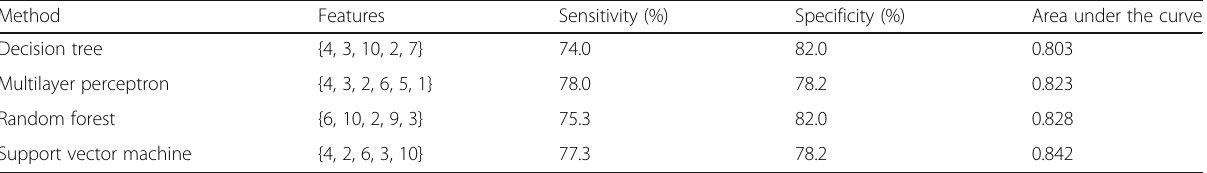
Table 8 Performance of different machine learning methods obtained by Shan et al. [8]